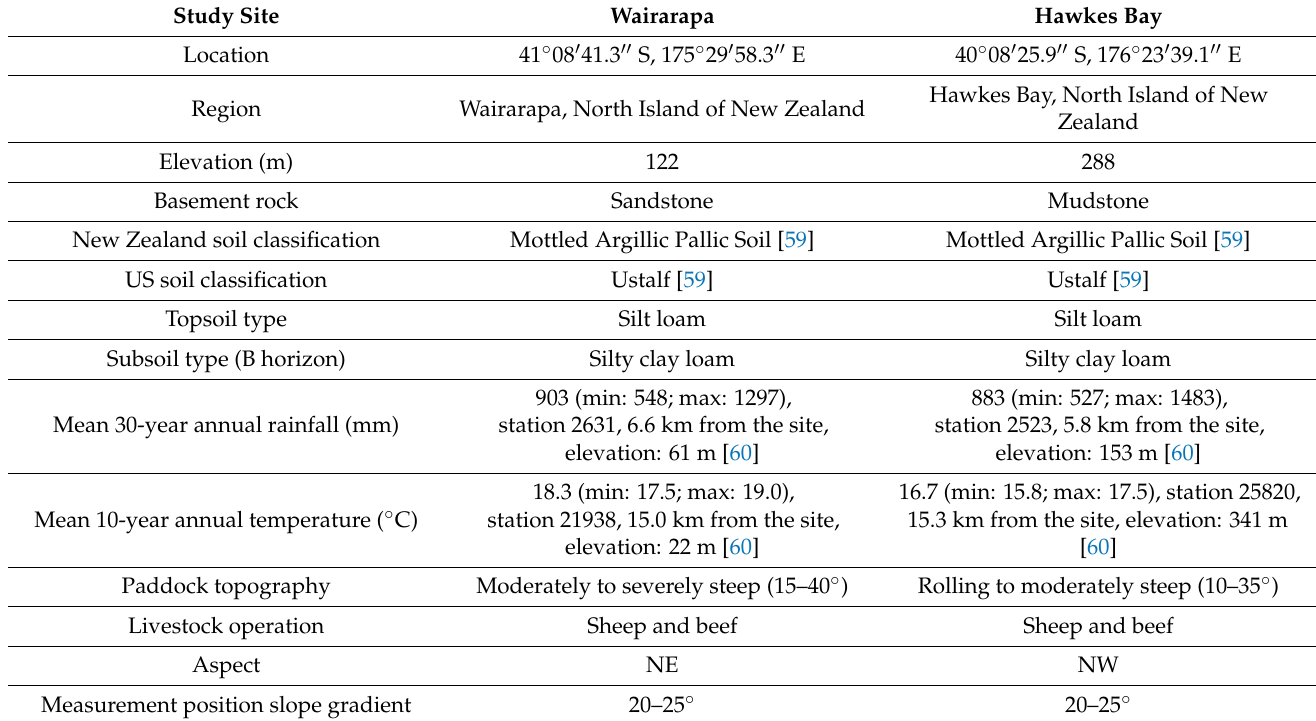
Table 1. Site characteristics for the two study